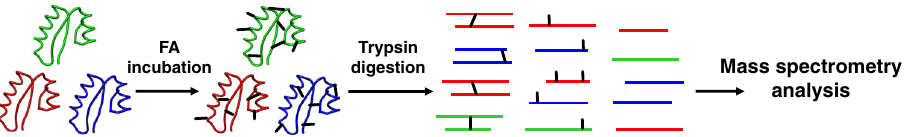
Fig. 1 The experimental setup for cross-linking of structured proteins by FA. The tryptic digest consists of a mixture of linear peptides, linear peptides with FA-induced modi fi cations, and cross-linked peptide